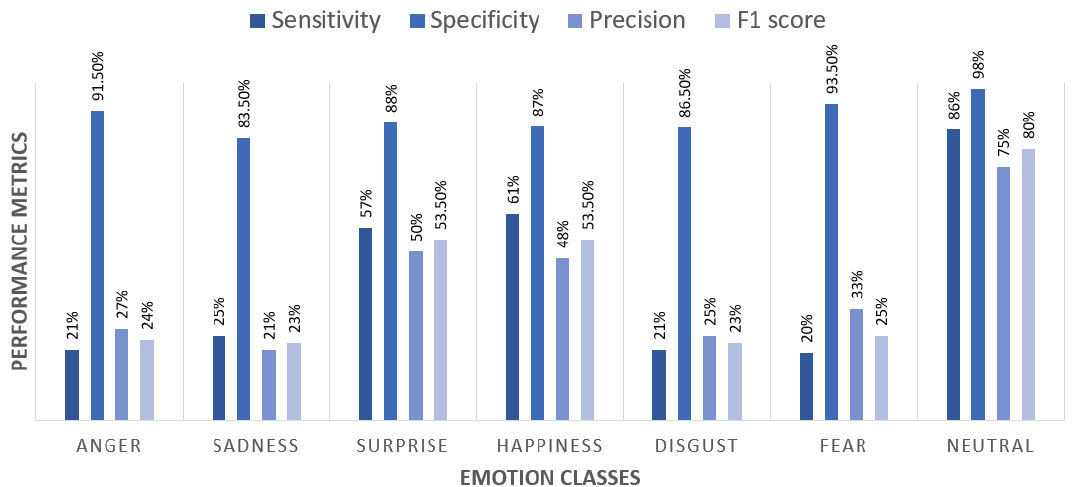
Figure 5. Comparison of the sensitivity, specificity, precision and F1 score metrics computed for the single emotion classes when considering the best combination of DA techniques, i.e., GAN, HR and TR. Training database, KDEF; testing database,